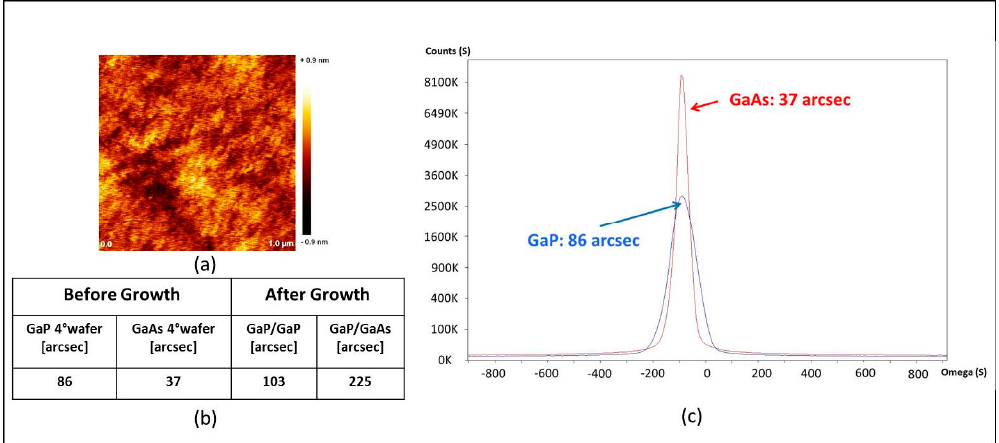
Figure 14. ( a ) Atomic-force microscopy (AFM) images (1 µm × 1 µm square) of HVPE growth of GaP on GaAs show smooth surface morphology; ( b ) Full Width of Half Maximum (FWHM) omega-scan of GaP and GaAs substrate surfaces before growth and the related results after HVPE homo- and heteroepitaxy [59]. (Reproduced from [59] with the permission of OSA); ( c ) Reflection curves of omega-scans of a GaP and a GaAs substrate before the HVPE growth.